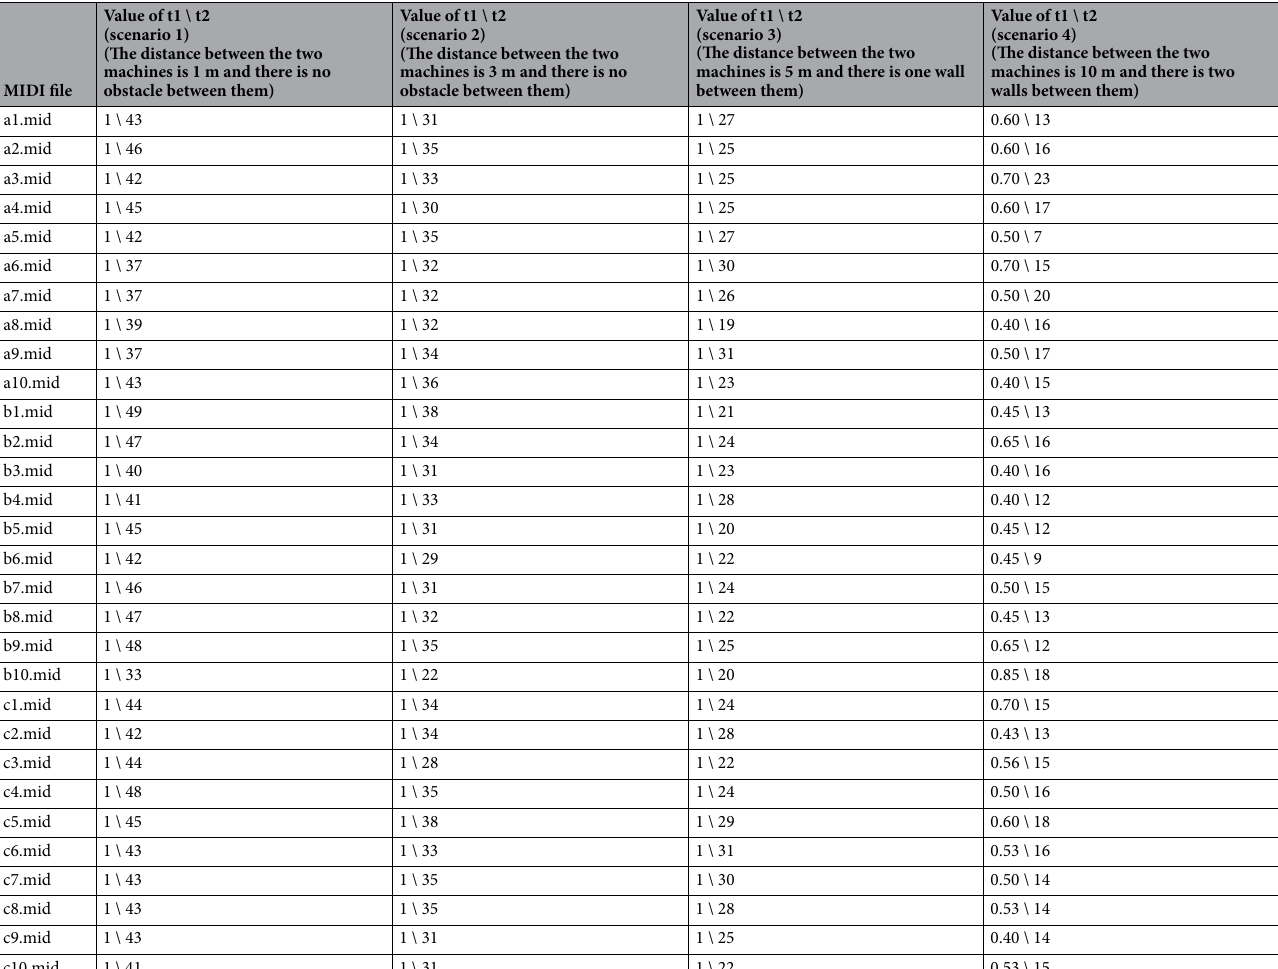
Table 7. The result of recognition when one machine plays MIDI files with a loudspeaker and another machine picks up the sound and tries to recognize it using Bideyuanli (the average decibels d1 measured at the loudspeaker remain unchanged, the average decibels d2 measured at the pickup change, and the background noise is d3 decibels) Let t1 = m/n, if a URL has n characters and m characters are recognized correctly, as well as t2 = d2-d3.